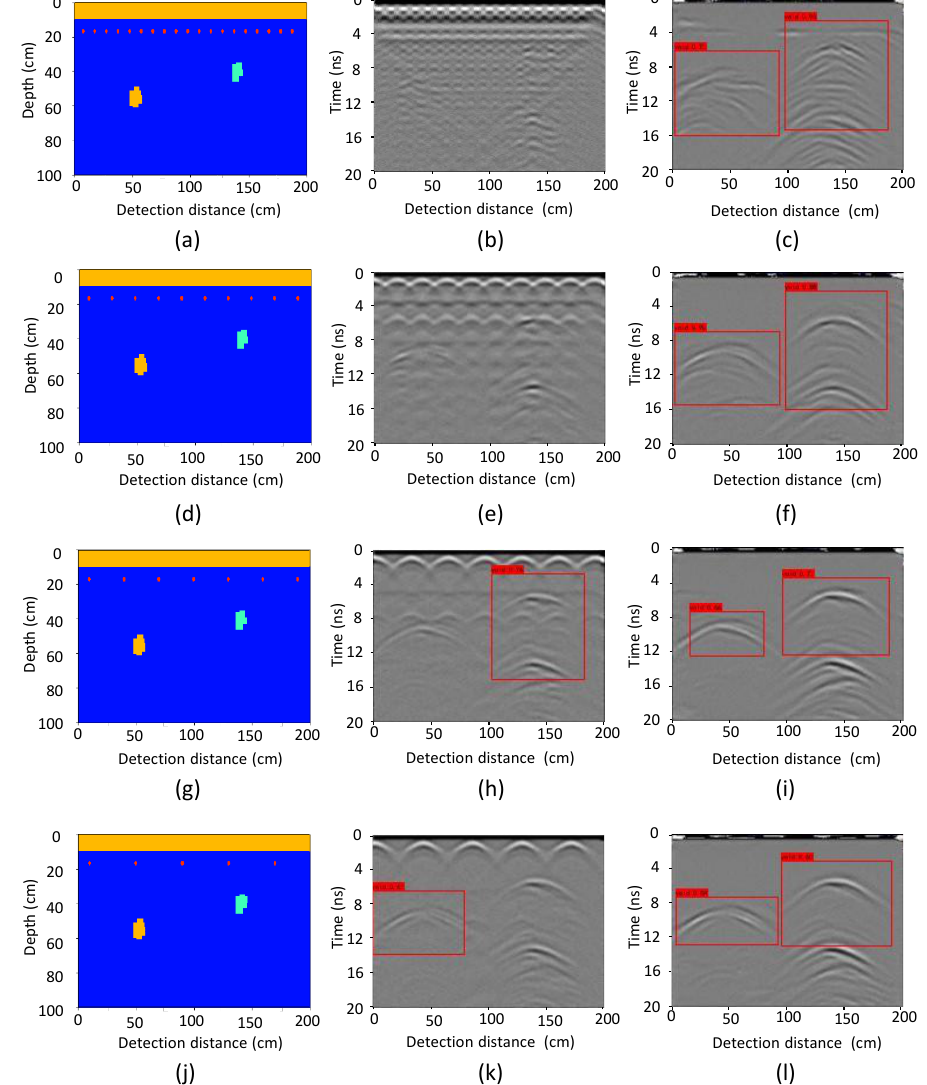
Figure 8. Detection results on testing dataset I. The four rows from top to bottom ( a - c ; d – f ; g – i ; j – l ) represent four cases with rebar spacing of 10, 20, 30, and 40 cm, respectively. The left, middle, and right column denotes the FDTD permittivity models, YOLOv4 detection results on the original GPR images, and on the RCE-GAN processed images,